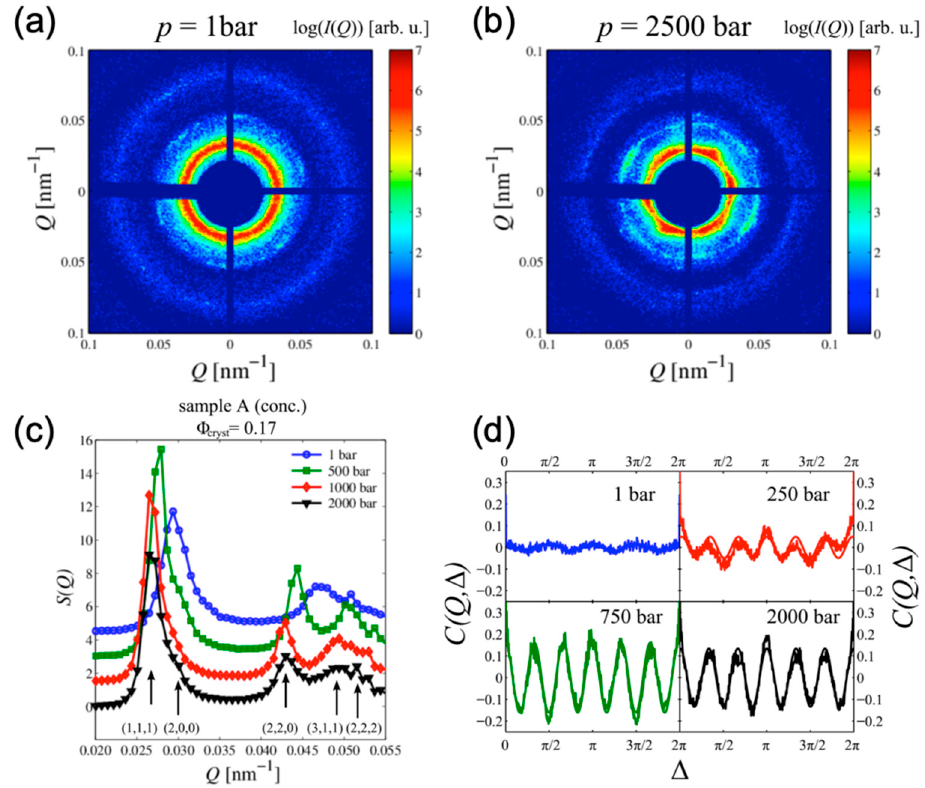
Figure 14. ( a , b ) Di ff raction patterns from solution of charge-stabilized polyacrylate particles suspended in water at ambient pressure ( a ) and under pressure of 2500 bar ( b ). ( c ) Evolution of the structure factor under applied pressure. ( d ) Evolution of the cross-correlation function C ( Q , ∆ ) under increasing pressure directly reveals the development of BO order (reprinted from Schroer et al. [86], with permission of AIP Publishing).